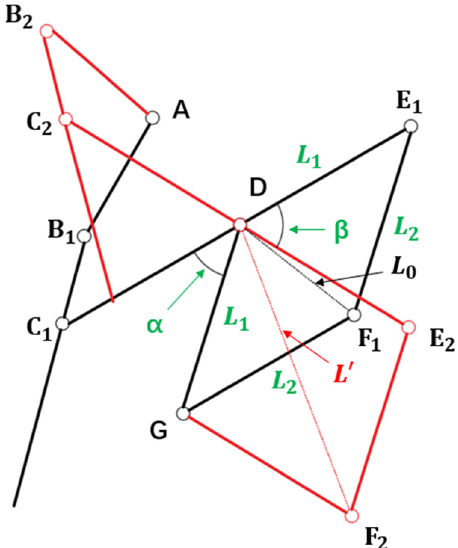
Figure 6. Mathematical model of a six ‐ link mechanism.